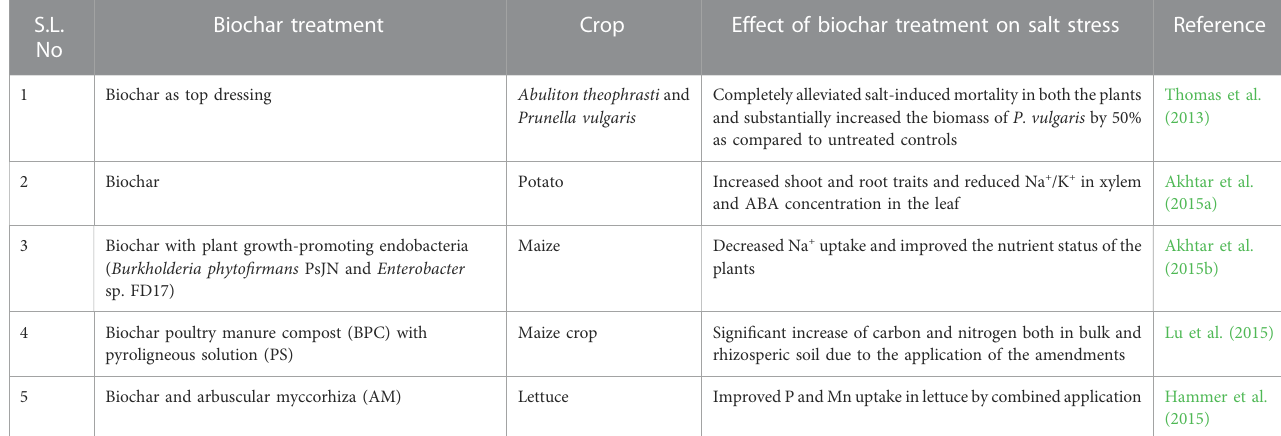
TABLE 3 Role of biochar in improving crop tolerance to salinity stress when applied alone or in combinations.